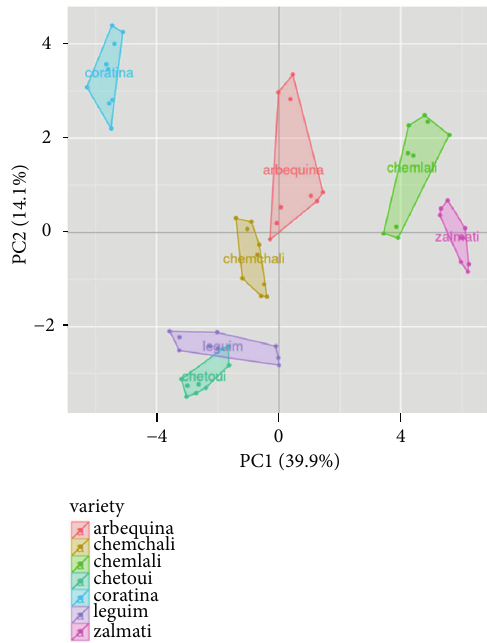
Figure 3: Projection of the seven cultivars in the space defined by the first two principal Table 6: Results of the ANOVA on mean liking scores.